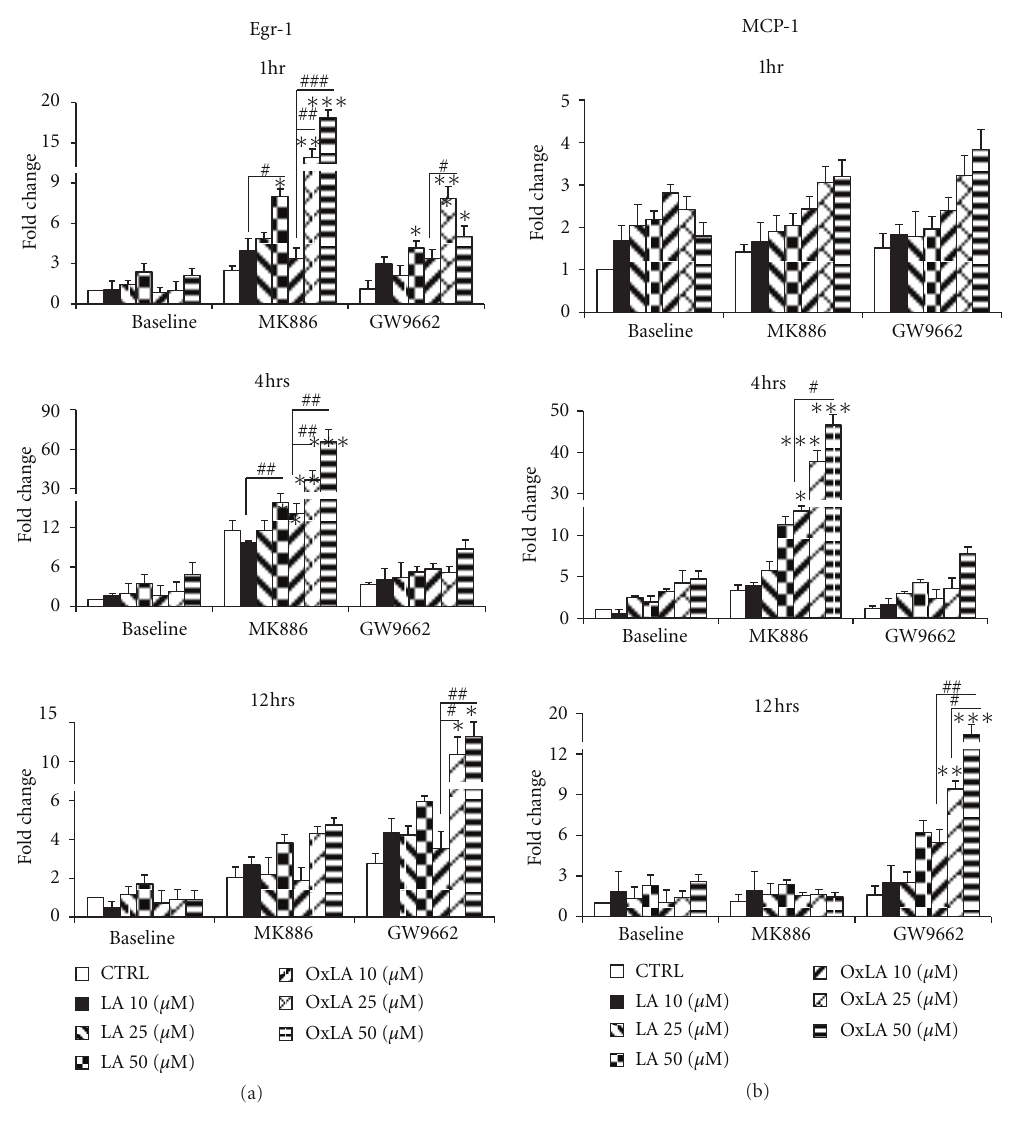
Figure 2: Ligand-mediated regulation of PPAR transactivity altered Egr-1/MCP-1 mRNA levels. Downregulation of PPAR α or γ by pretreatment of RASMCs with 10 μ M MK886 or 1 μ M GW9662 followed by exposure to 10–50 μ M LA or OxLA for 1–12 hrs resulted in time-dependent induction of Egr-1 and MCP-1 mRNA levels as analyzed using qRT-PCR. Control-(CTRL-) vehicle only. mRNA levels were expressed as fold change ± SEM (Standard error of Δ CT mean). (a) Egr-1 mRNA levels at 1, 4 and 12hrs; (b) MCP-1 mRNA levels at 1hr, 4 and 12hrs. One way ANOVA was used for comparison between two treatments. Significance was confirmed using Fisher LSD test. ∗ compared to CTRL, # compared to 10 μ M